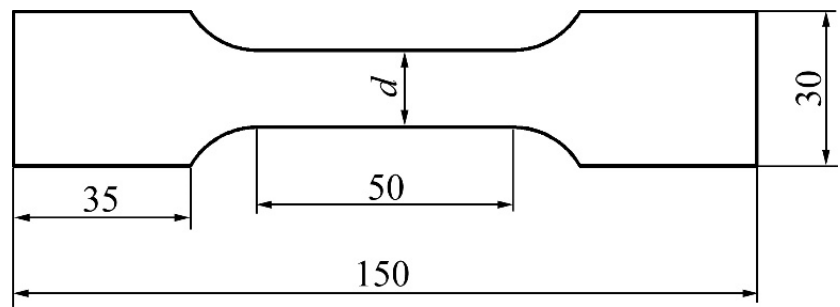
Figure 1. The inner panel of the engine hood and the key local features.